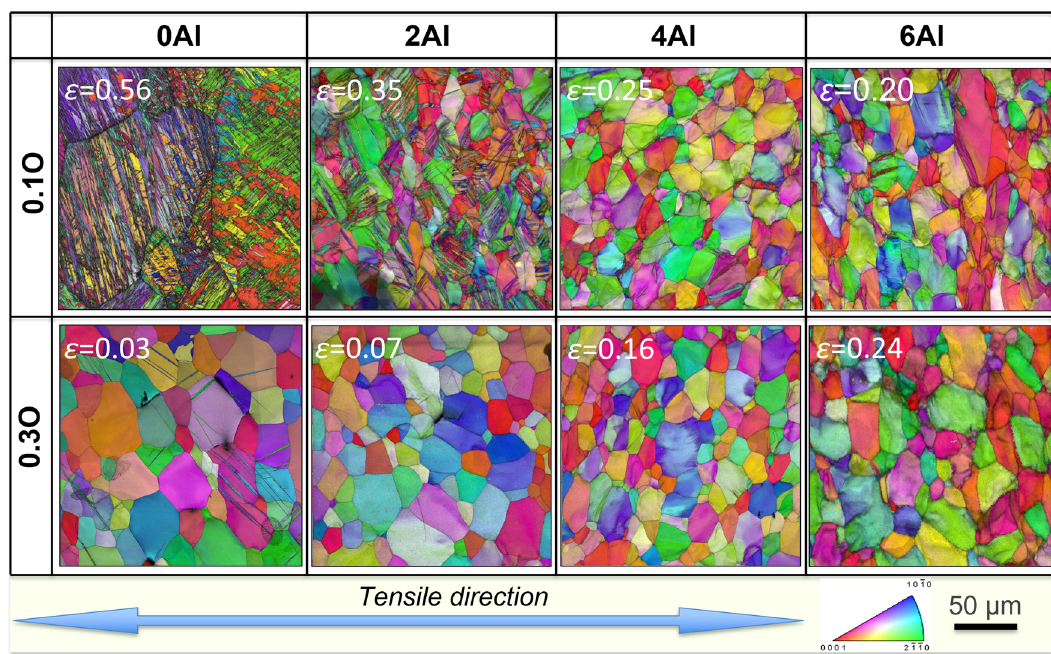
Fig. 2 EBSD inverse pole fi gure (IPF) + image quality (IQ) maps of Ti-O and Ti-Al-O alloys after tensile fracture in liquid nitrogen. The fracture strain was also indicated in each microstructure. When the oxygen content is 0.1 wt%, the deformation twinning was basically suppressed with 4wt.% of aluminum addition, whereas when the oxygen content is 0.3 wt%, the deformation twinning was basically suppressed with 2wt.% of aluminum addition. The scale bar applies to all panels in this fi